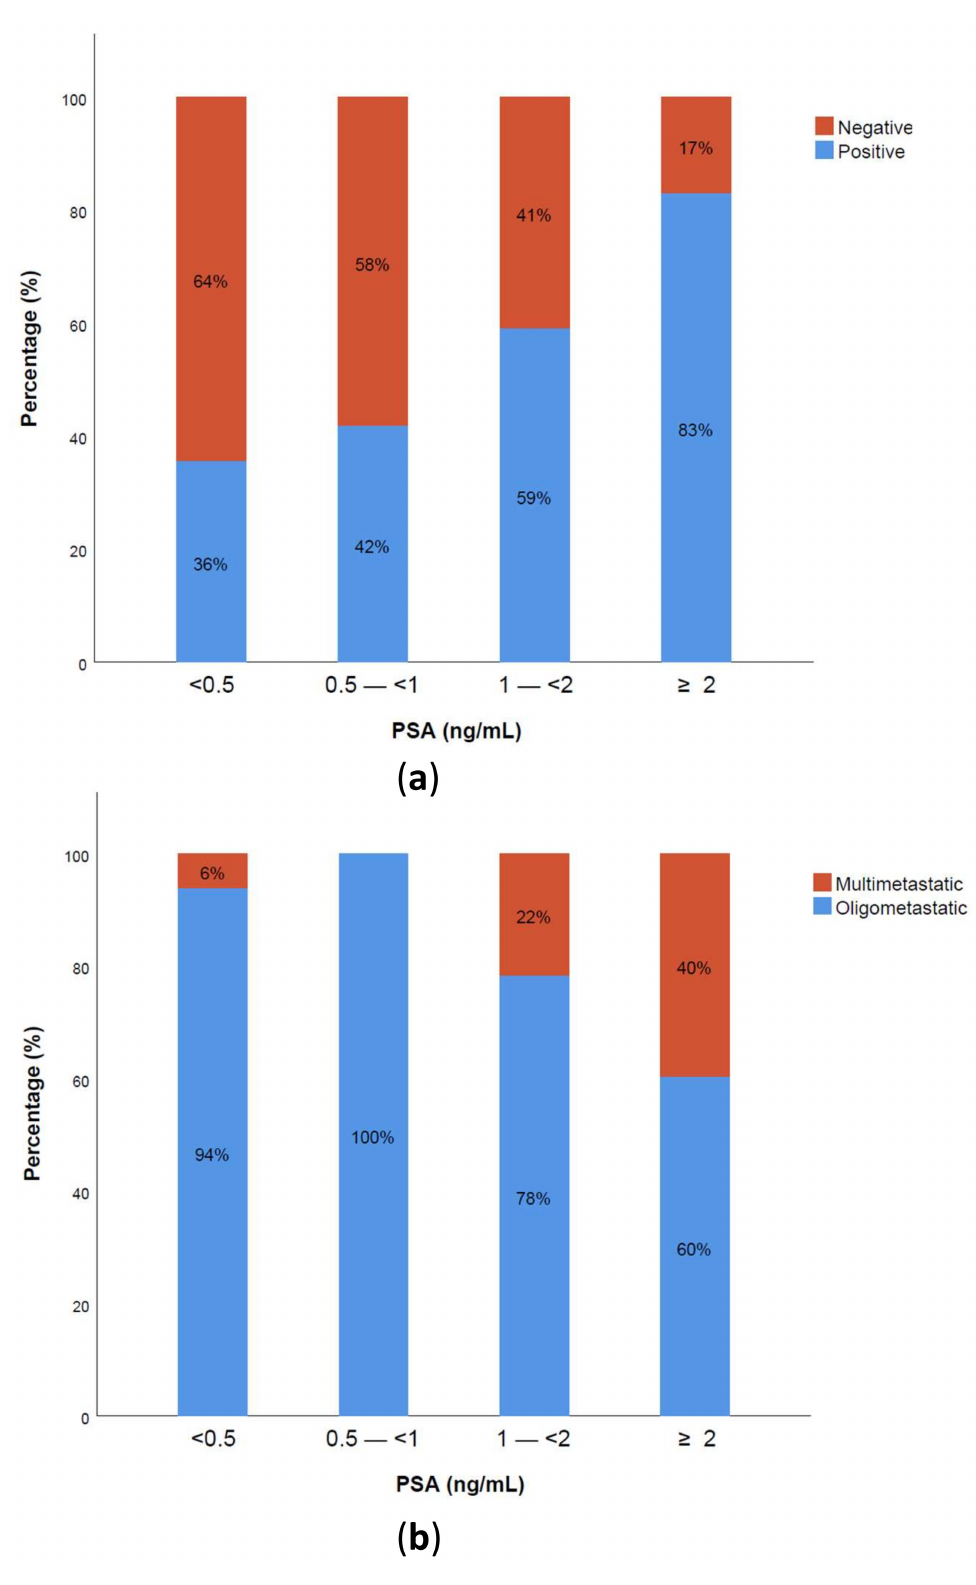
Figure 1. 68 Ga-PSMA PET/CT positivity rate and oligometastatic disease detection rate related to PSA levels. ( a ) Positive versus negative PSMA-PET/CT; ( b ) oligometastatic vs. multimetastatic disease